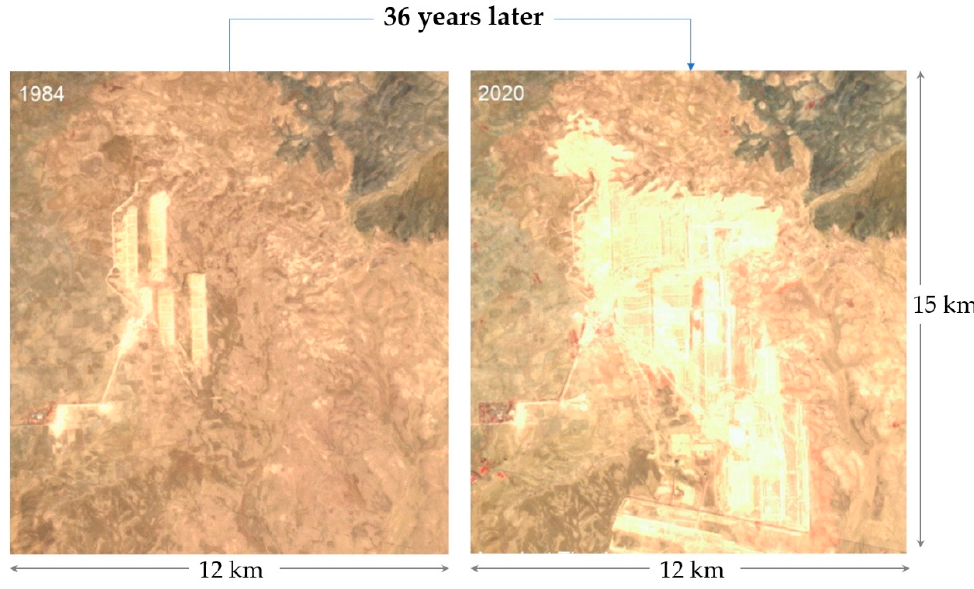
Figure 5. Satellite views of waste rock dumps evolution in the Gantour region in Morocco (1984 and 2020).